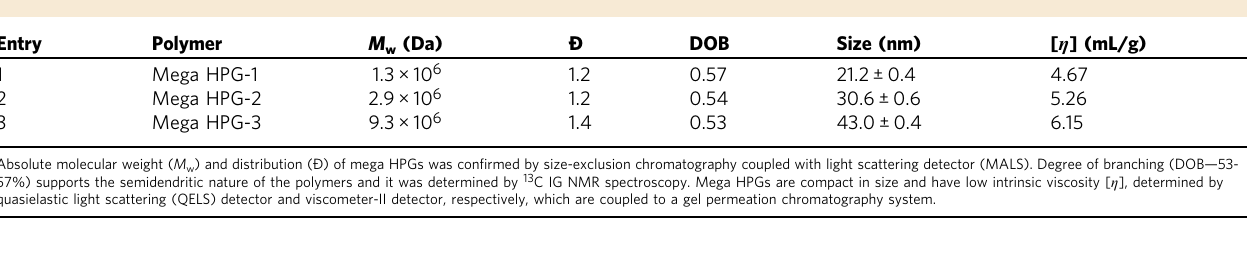
Table 1 Physical characteristics of mega HPGs.